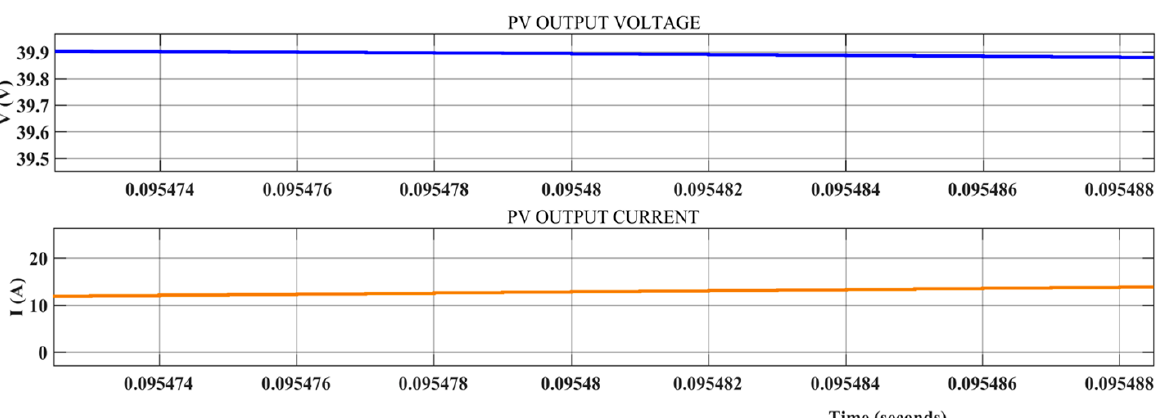
Figure 8. Pulses generated for switches S 1 , S 2 , S 3 and S 4 (bidirectional). The PV fed the converter when there is solar irradiance. Applying MPPT controller to the PV panel, 40 V output voltage is constantly maintained, which fed the load through the Zeta converter. This was facilitated by triggering switch S 1 . Figure 9 shows the output voltage and current fed from the PV at a constant irradiance. At a particular irradiance, the output current of PV will be constant only. This current will change only when the irradiance will change.